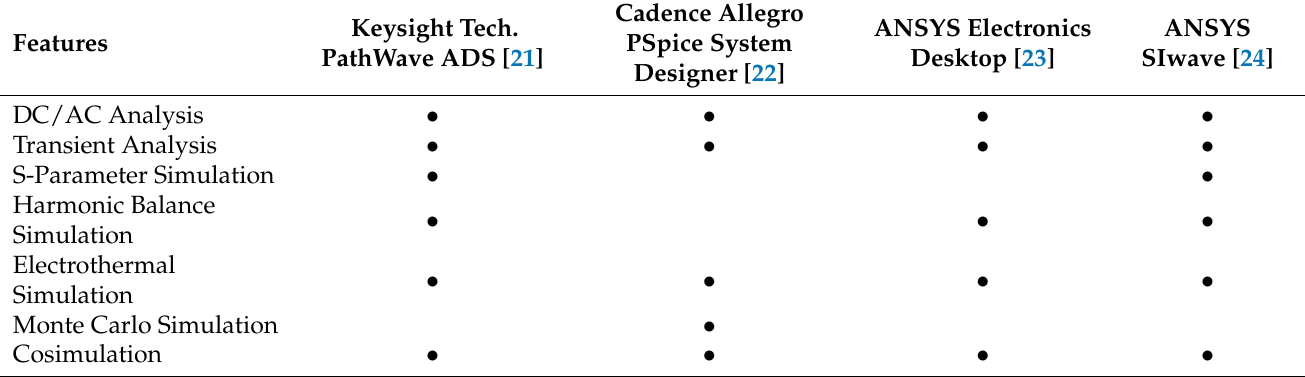
Table 1. Comparison of the main features of power electronics design software for time-domain schematic simulation.